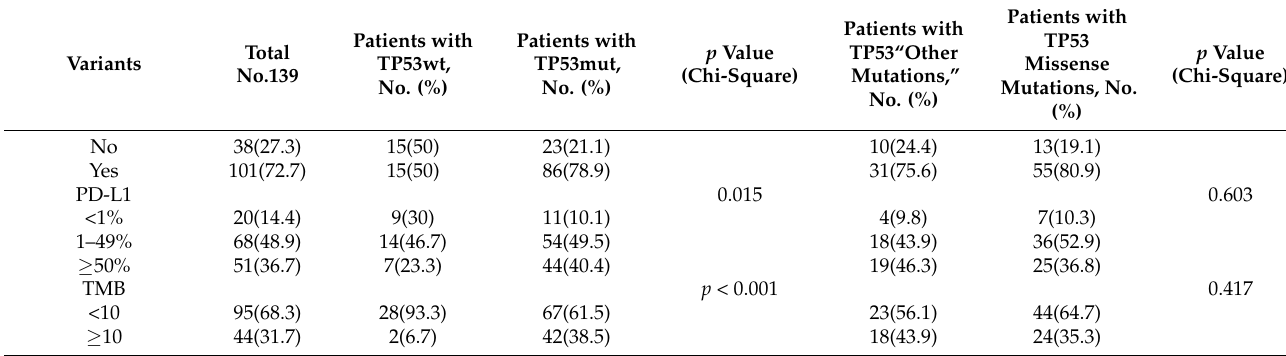
4 Table 1. Demographics and characteristics for patients with TP53wt and TP53mut in advanced lung cancer. Variants